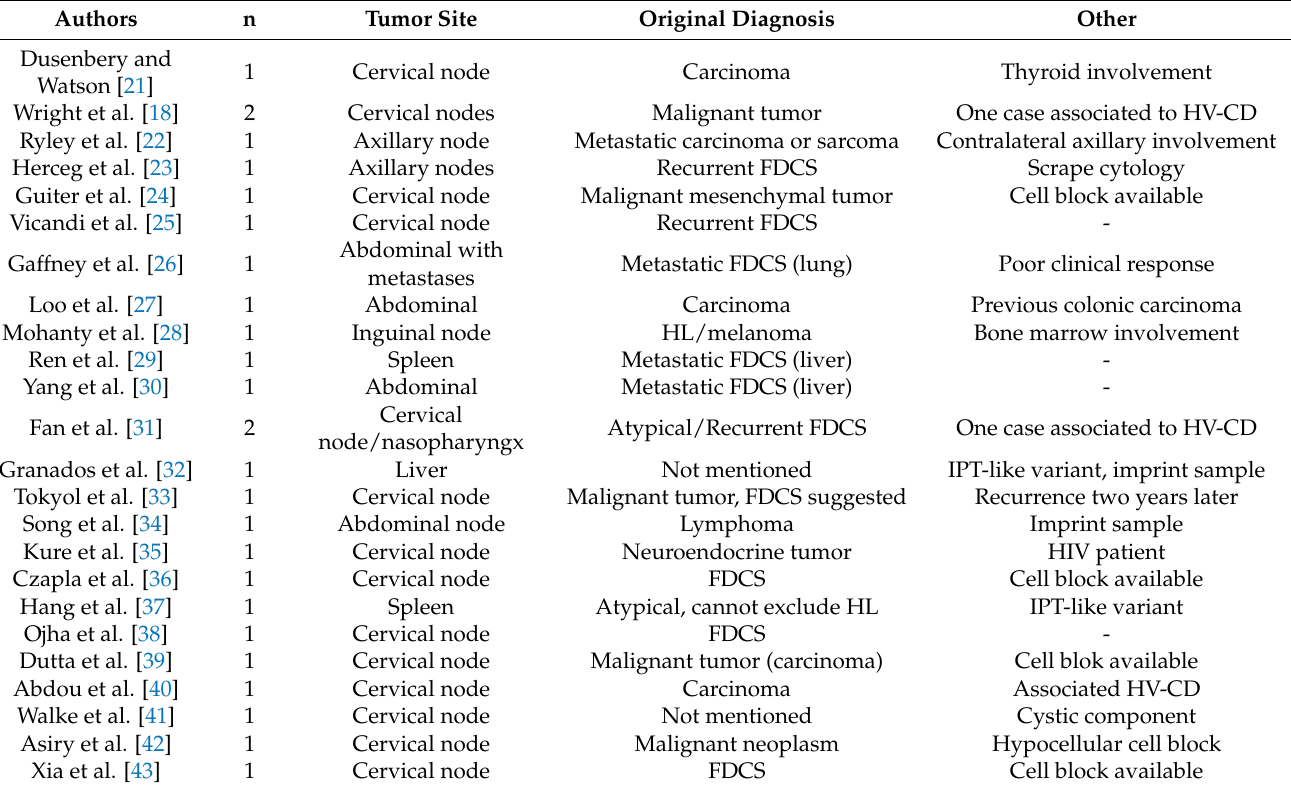
Table 1. Reported cytological studies of follicular dendritic cell